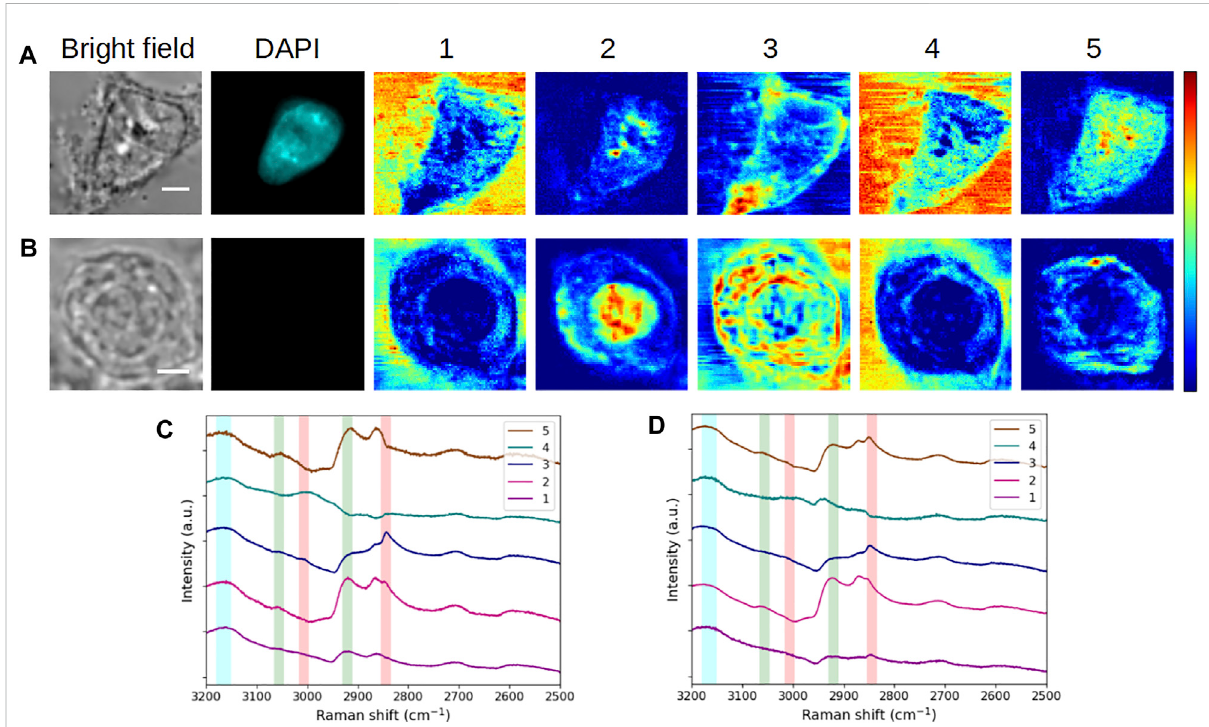
FIGURE 4 Comparative analysis of fi xed HEK293 cells in (A,C) interphase (G 1 /S) and (B,D) mitosis (prophase). (A,B) Bright- fi eld and fl uorescence images and concentration maps obtained for the fi ve computed components. The scale bar corresponds to 5 μ m. (C,D) Spectra corresponding to (A,B) , respectively. Vertical bars highlight the presence of lipids (red), proteins (green), and water (blue). After fi xation, the interphase cell was stained with